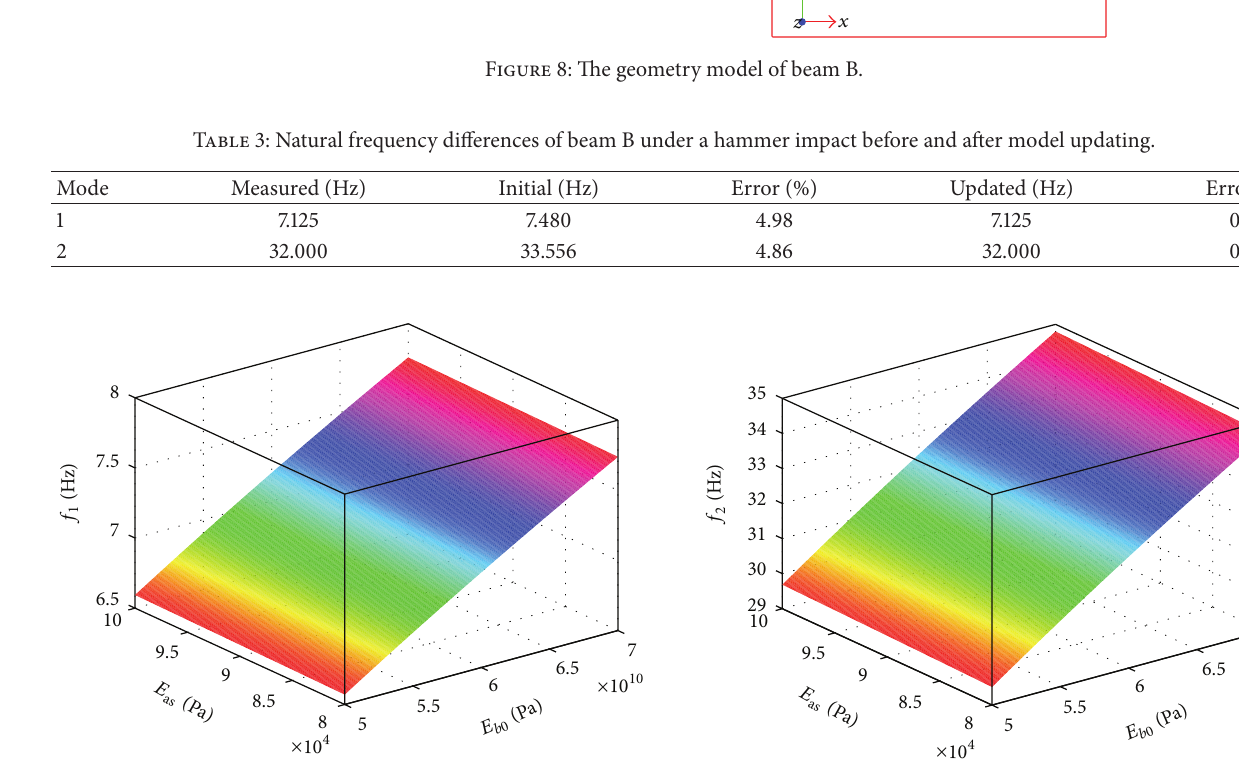
Figure 9: Predicted values of the first natural frequency. Figure 10: Predicted values of the second natural